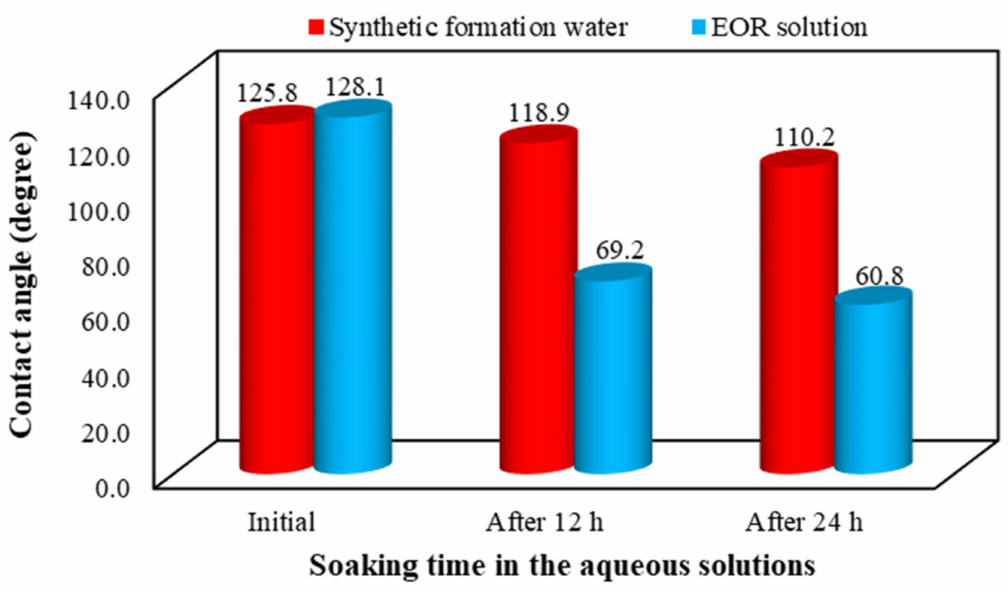
Figure 13. E ff ects of soaking time of the rock sections in red: synthetic formation water and blue: the enhanced oil recovery (EOR) solution on the oil-rock contact angle.